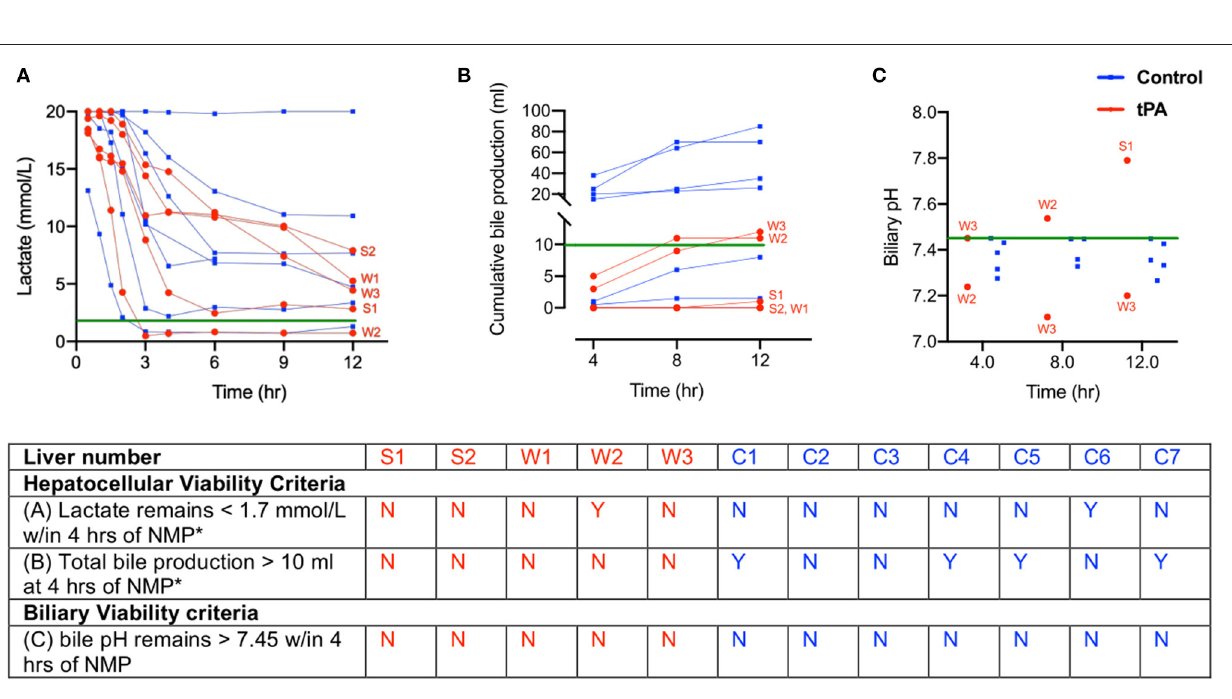
Frontiers in Surgery |